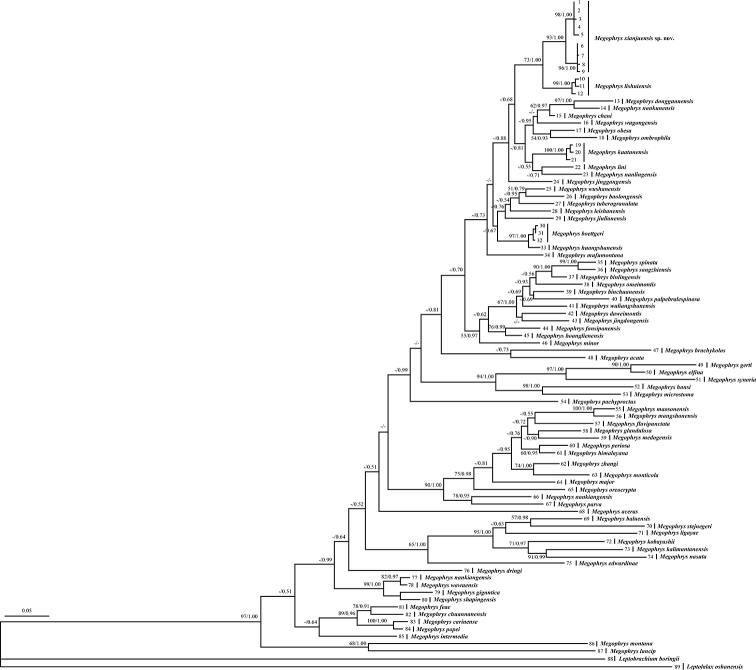
Maximum Likelihood tree of the genus Megophrys reconstructed based on the 16S rRNA and COI gene sequences. ML bootstrap support/Bayesian posterior probability was denoted beside each node. Samples 1-89 refer to Table 1.